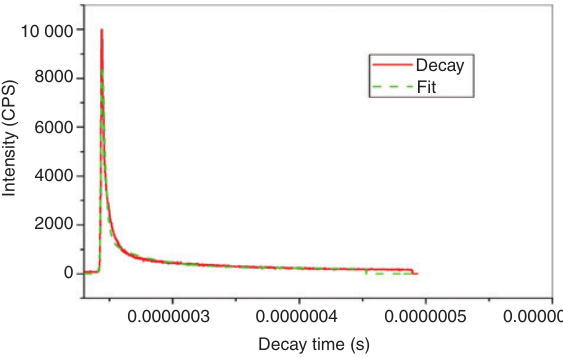
Figure 11: The solid state luminescent lifetime of the